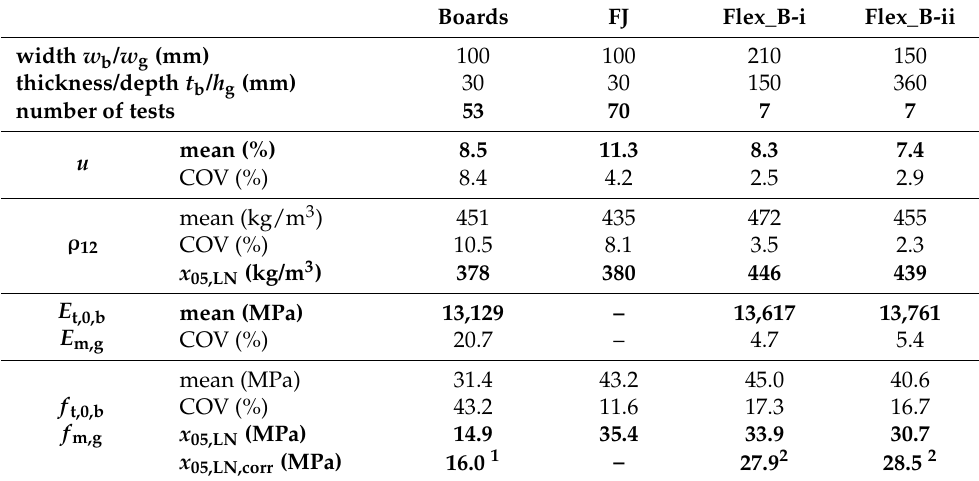
Table 15. Results of tensile tests parallel to the grain on boards, flatwise bending tests on finger joints, and bending tests on two series of flex_GLT type B beams from Sieder and Brandner [44]. Boards FJ Flex_B-i Flex_B-ii width w b / w g (mm) 100 100